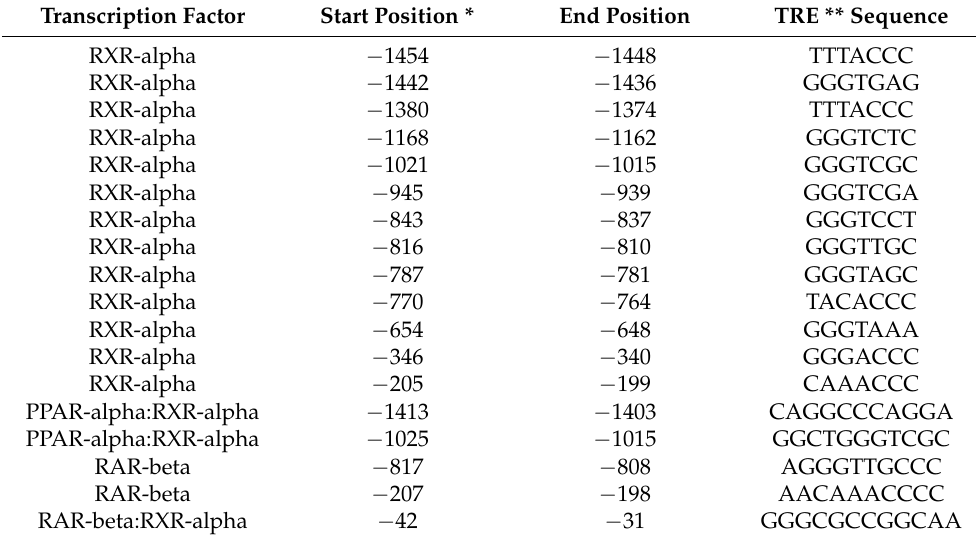
Table 1. List of RAR and RXR binding sites found in the HOXA9 promoter.